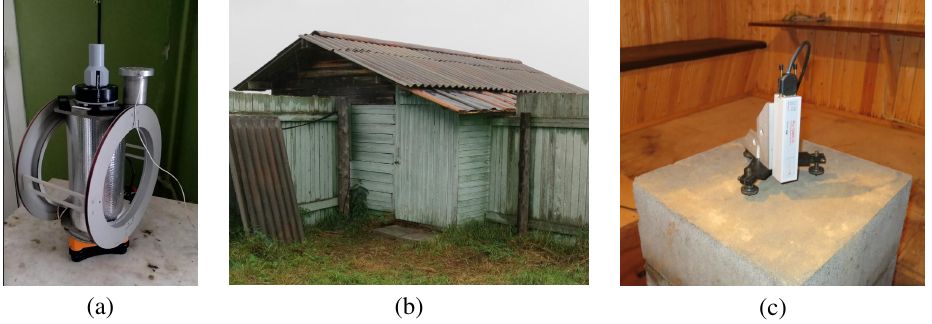
Figure 11. POS-4 magnetometer (IZMIRAN): (a) a testing of POS-4 in the absolute pavilion of the Observatory Moscow; (b) a pavilion for installing of POS-4 at the IZMIRAN station in the village Vaimusha; (c) a pillar inside the pavilion with a fluxgate